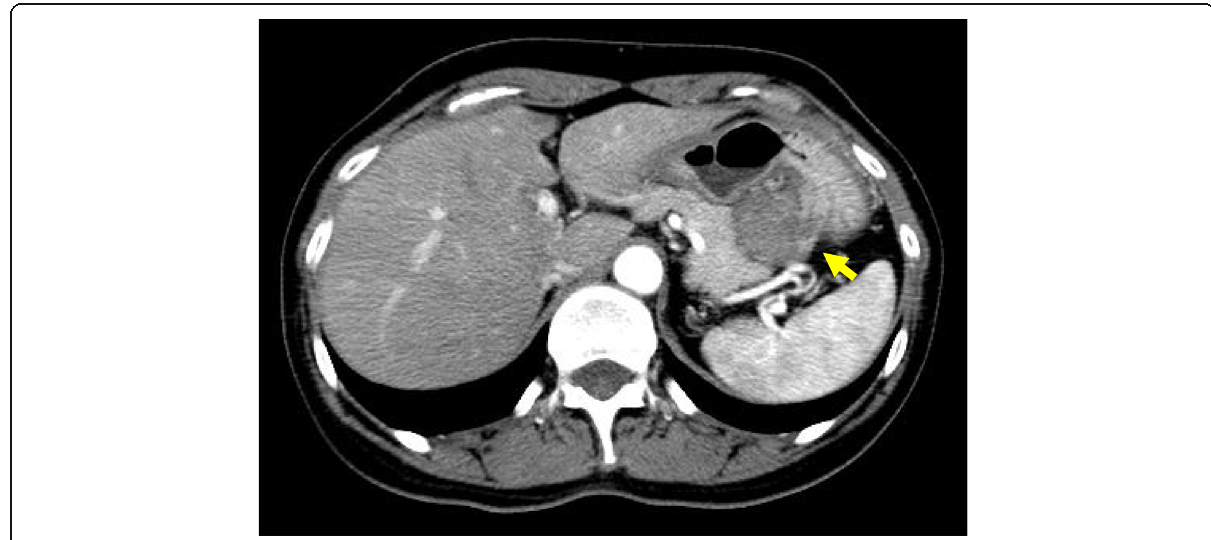
Fig. 2 Dynamic and contrast-enhanced CT showed a 30 × 25 × 50-mm solid mass (yellow arrow) between the stomach and the pancreas tail. The lesion had a smooth margin and an inhomogeneously moderate enhancement in the arterial